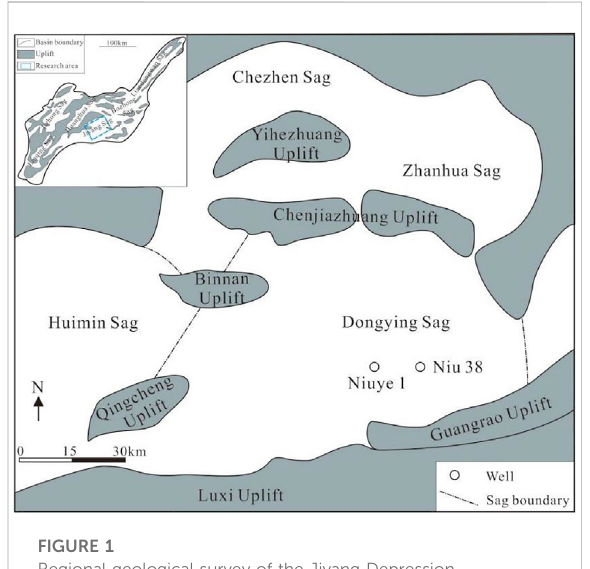
FIGURE 1 Regional geological survey of the Jiyang